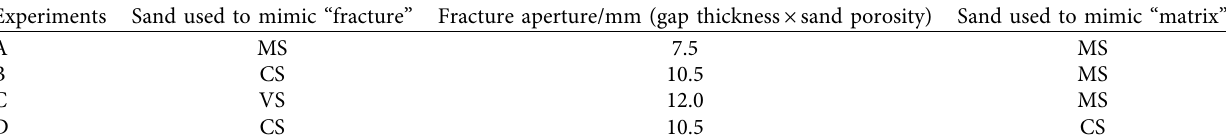
Table 2: Experimental conditions showing different combinations of sand selected to mimic “Fracture” and “Matrix.” Experiments